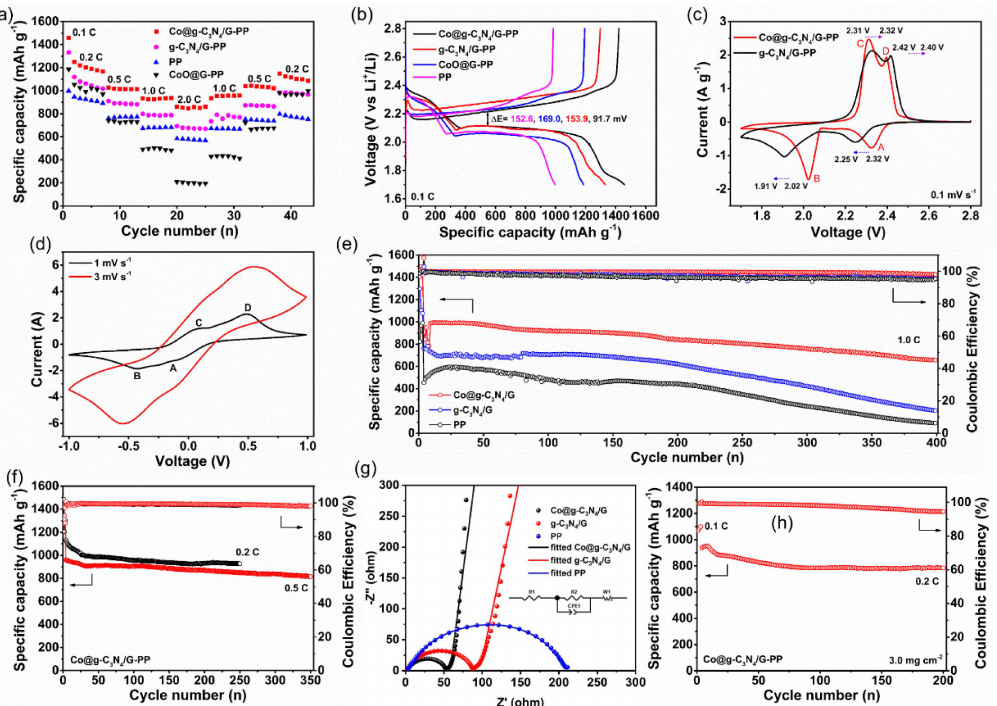
Figure 6. ( a ) Rate performances and ( b ) charge–discharge profiles at 0.1 C of Li-S cells with differ- ent separators. CV curves of ( c ) cells with g-C 3 N 4 /G-PP and Co@g-C 3 N 4 /G-PP separators and ( d ) symmetric cells using two Co@g-C 3 N 4 /G electrodes. ( e , f ) Cycling performances at different rates of cells with corresponding separators. ( g ) EIS spectra of cells with PP, g-C 3 N 4 /G-PP, and Co@g- C 3 N 4 /G-PP separators. ( h ) Cycling performance at 0.2 C of the cell using the Co@g-C 3 N 4 /G-PP separator with a high sulfur loading of 3.0 mg cm − 2